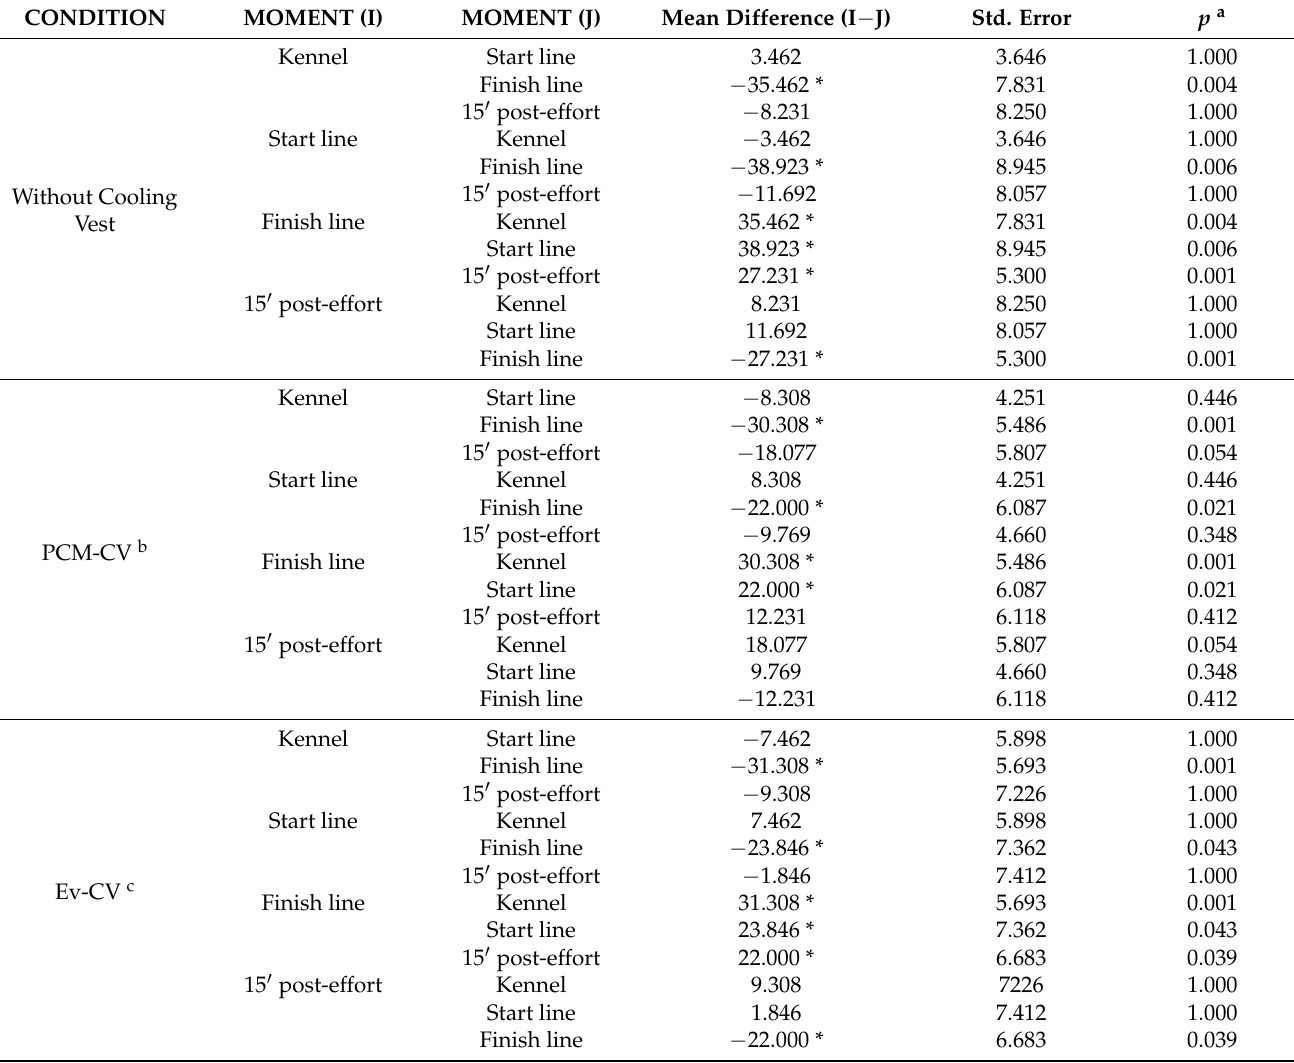
Table 14. Pairwise comparisons isolating the CONDITION factor. Measurement: pulse